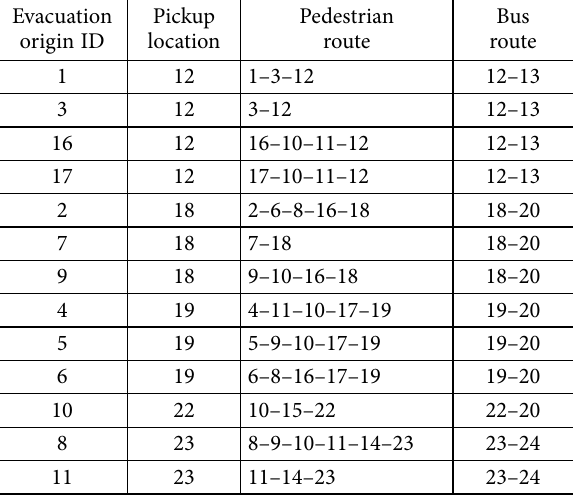
Table 5. Optimal results under Scenario 2 Evacuation origin